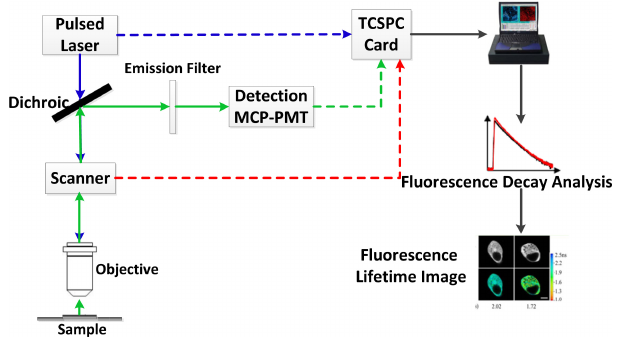
Fig. 5. Schematic diagram of TCSPC-based FLIM system.